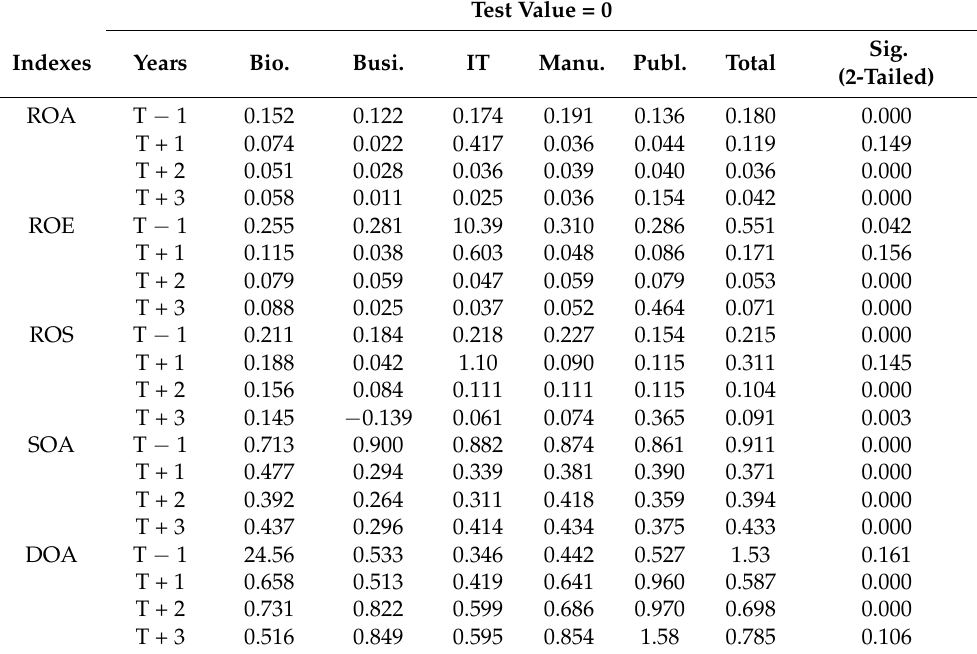
Table 1. Statistics of pre- and post-IPO operating performance by industrial